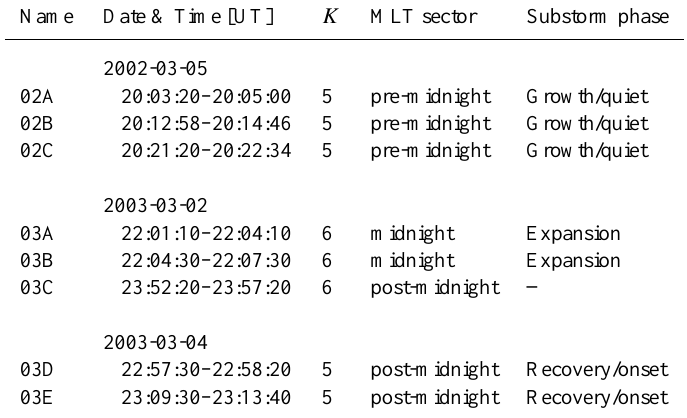
Table 1. Overview of events analyzed in this paper. K is the local 3-h averaged activity index.